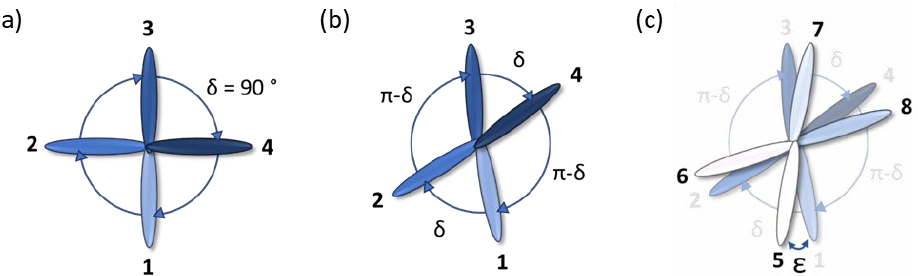
Figure 19. Schematic representations of the SmC TB phases using the clock model in which the ellipse represents the direction of the tilt projected onto the layer plane. ( a ) The ideal clock in which molecules rotate on the tilt cone by exactly 90 ◦ between consecutive layers. ( b ) The distorted clock in which the azimuthal angle between the projections of the long molecular axis in adjacent layers onto the smectic plane is no longer 90 ◦ . ( c ) A change in azimuthal angle to the adjacent layer causing the four-layer unit cell to rotate giving an additional helical structure.